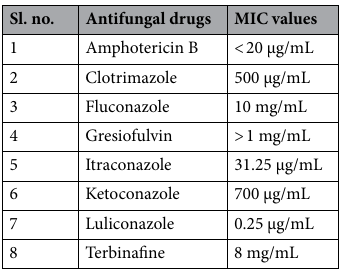
Table 1. MIC of antifungal drugs for Aspergillus fumigatus nHF-01 using agar well diffusion method.